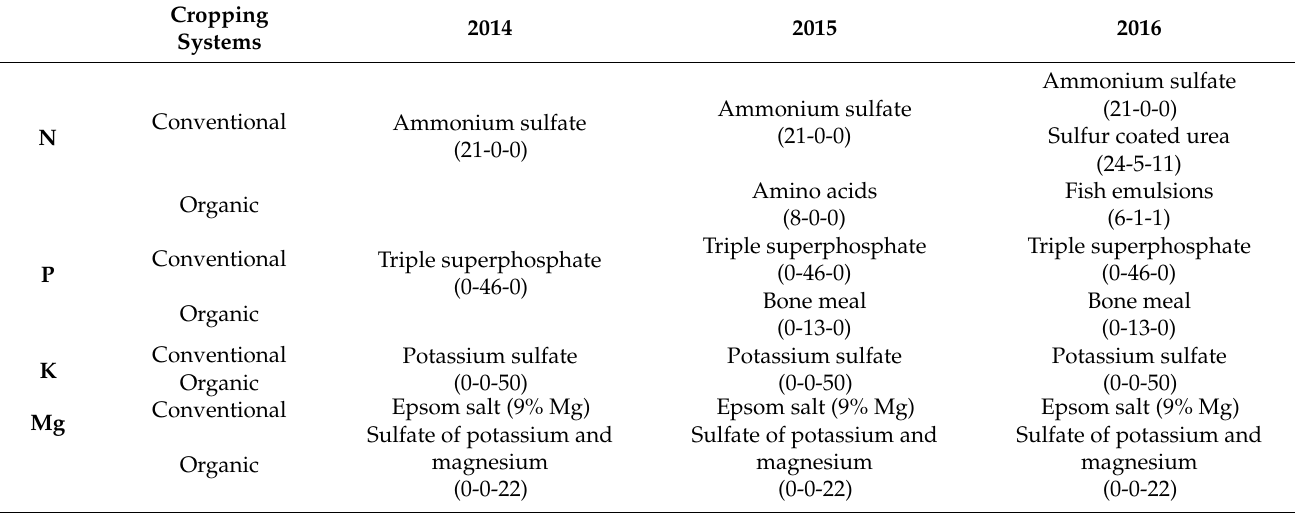
Figure A1. Monthly mean air temperature and total precipitation at the four experimental sites in Quebec, Canada. Table A1. Fertilizer regimes applied during the 3-year experimental period.